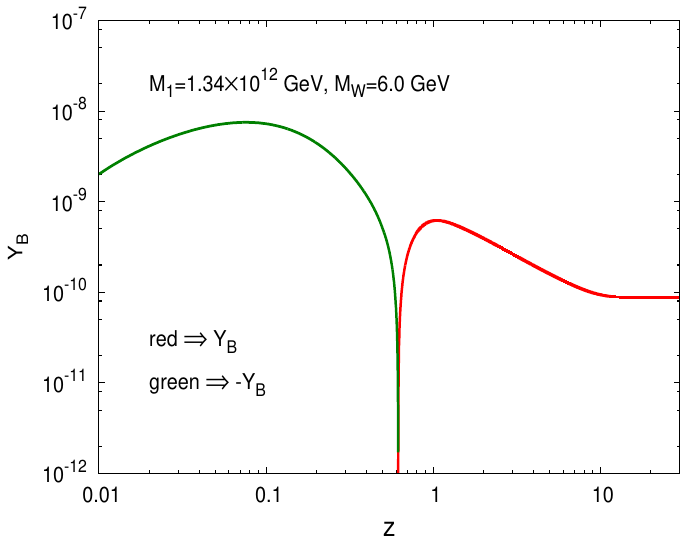
Figure 6 . variation of Y B with z for best (cid:12)t values of lagrangian parameters while the value of